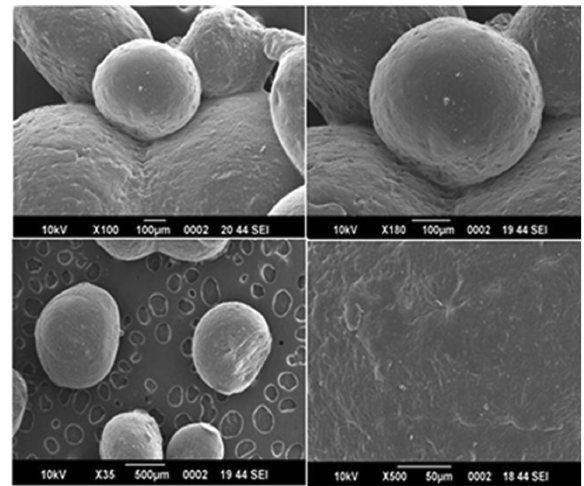
FIGURE 4 - Scanning electron microscopy of